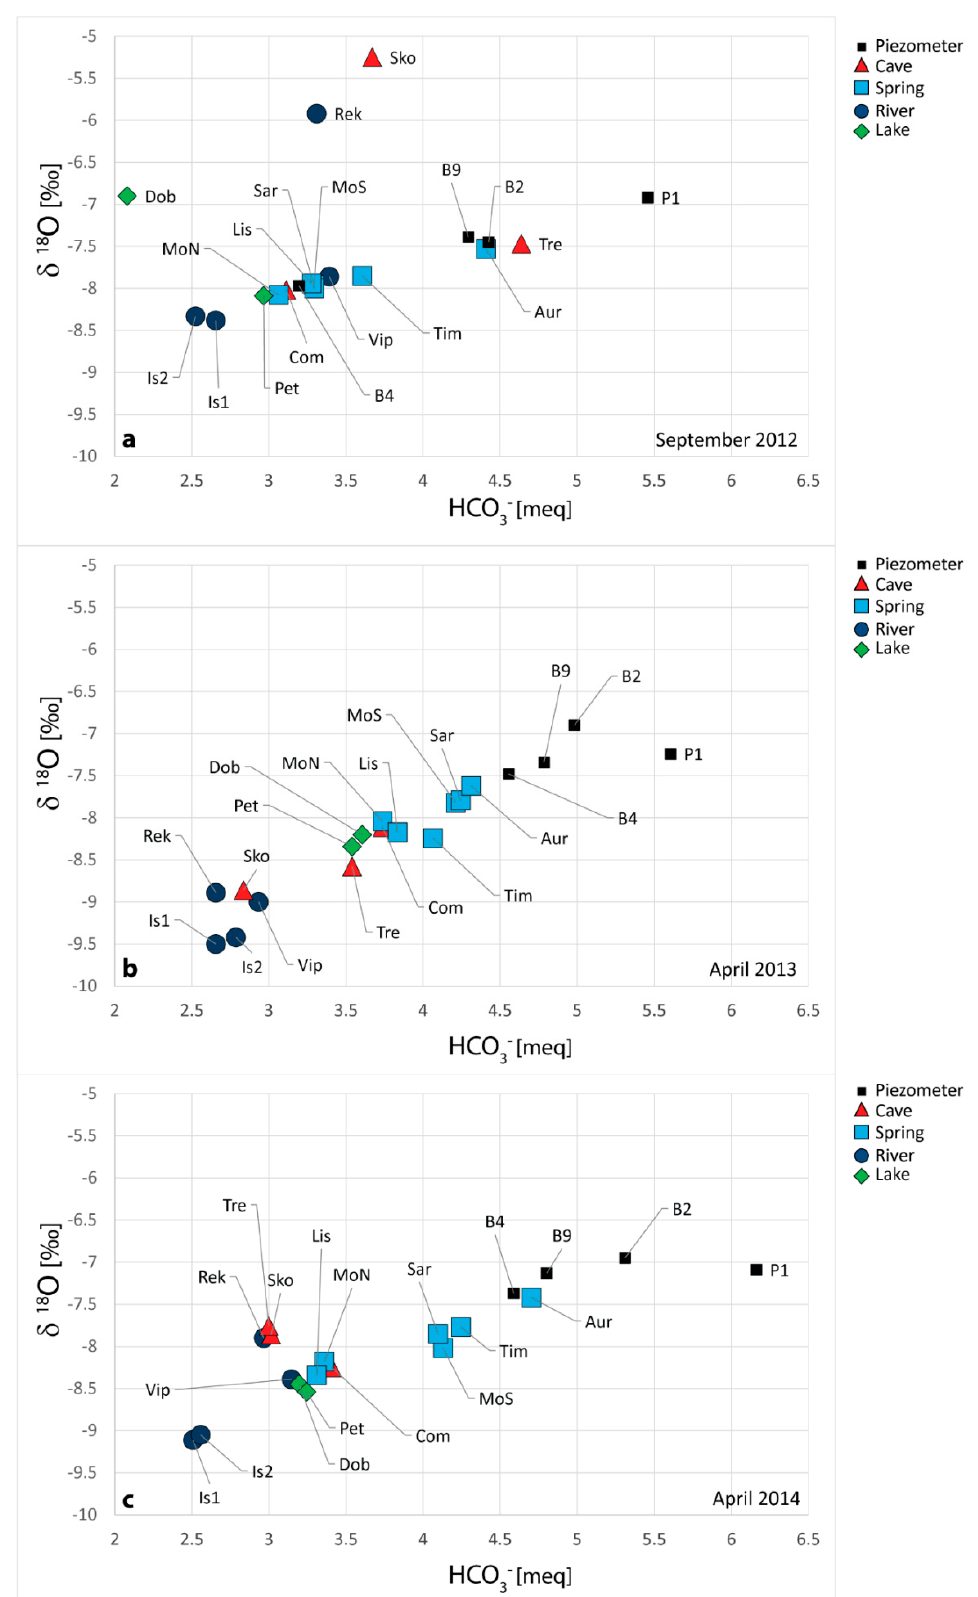
Figure 7. HCO 3 − (meq) versus δ 18 O (‰). The figure represents three specific hydrogeological conditions: ( a ) extreme low flow; ( b ) decreasing limb of a high flood; ( c ) decreasing limb of a moderate flood.